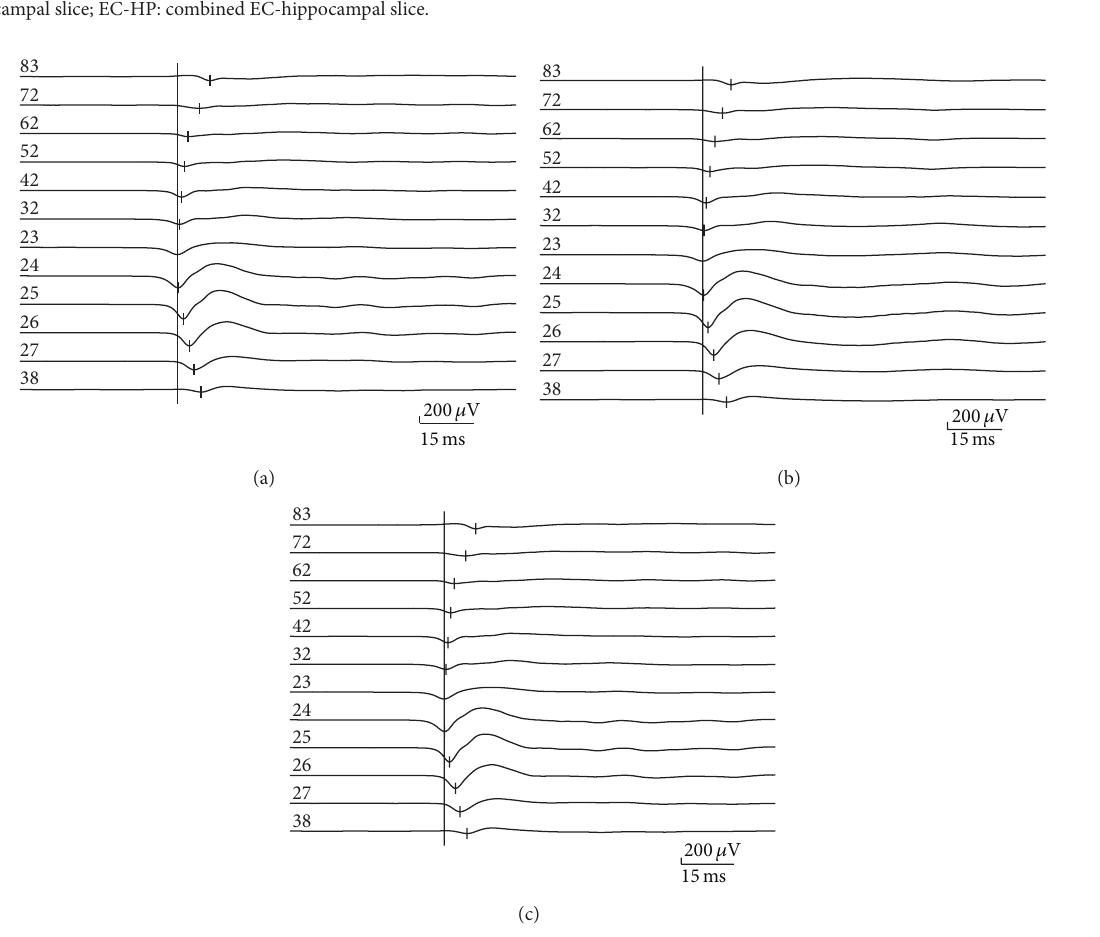
Figure 7: Effects of VPA on the initiation and propagation of the interictal discharges. The initiation and propagation of interictal discharge in an example of a hippocampal slice (Figure 2(a)) before (a), during (b), and after (c) application of 3mM